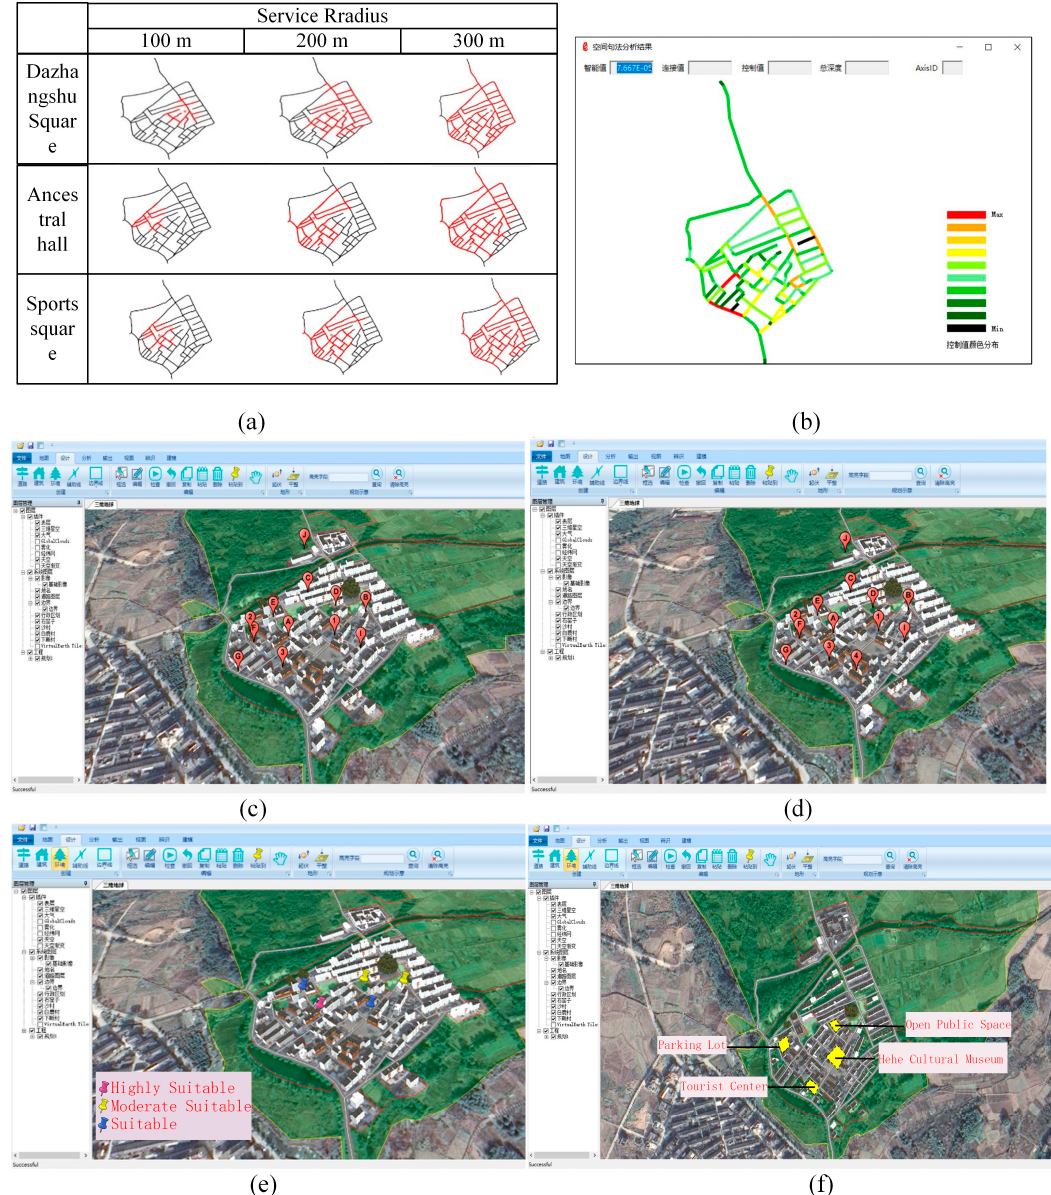
Figure 9. Site selection of public space using the scientific analysis and marking tools in XYEarth. ( a ) Service range analysis of current public spaces; ( b ) space syntax analysis of current road network; ( c ) initial candidate sites for new public spaces; ( d ) candidate sites for new public spaces after two rounds of discussion; ( e ) final candidate sites; ( f ) final design of public